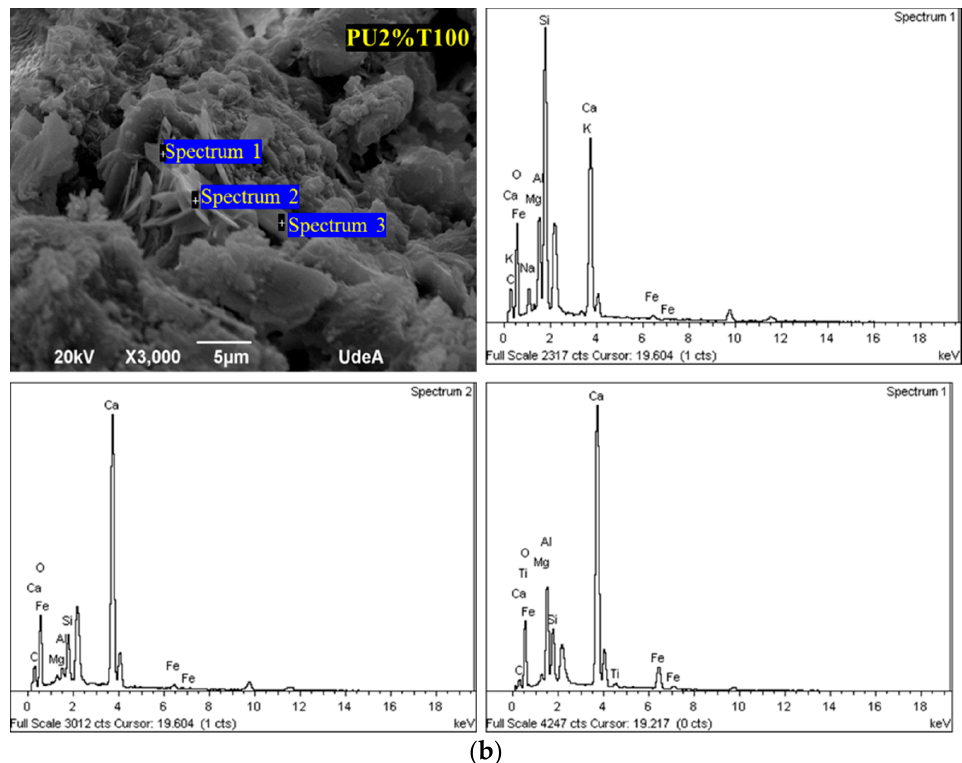
Figure 9. SEM–EDS analysis of mortars with polyurea retained in sieve 100: ( a ) PU5%T100; ( b ) PU2%T100.